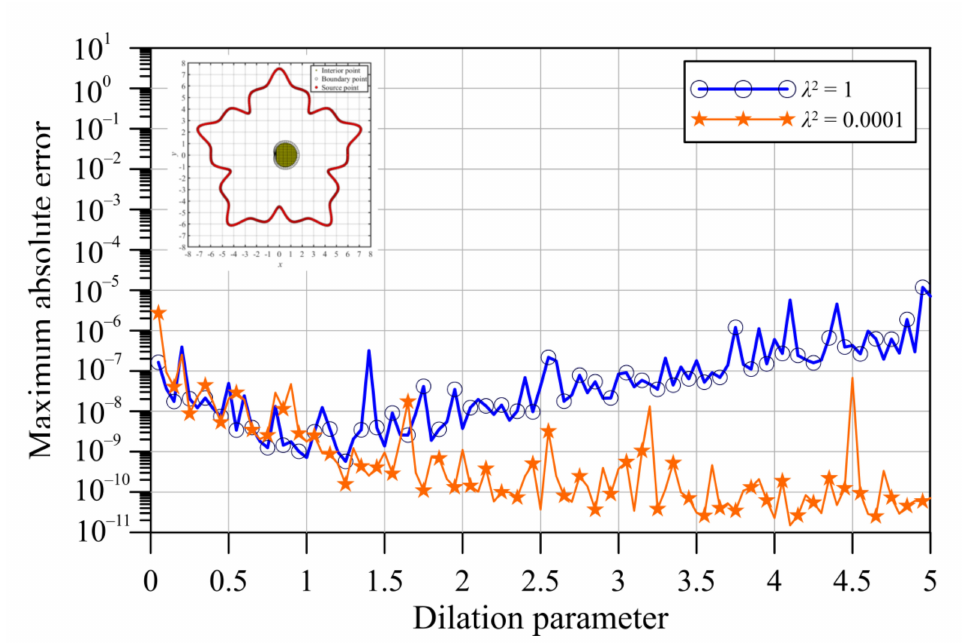
Figure 8. Maximum absolute error versus the dilation parameter ( k = 6 )